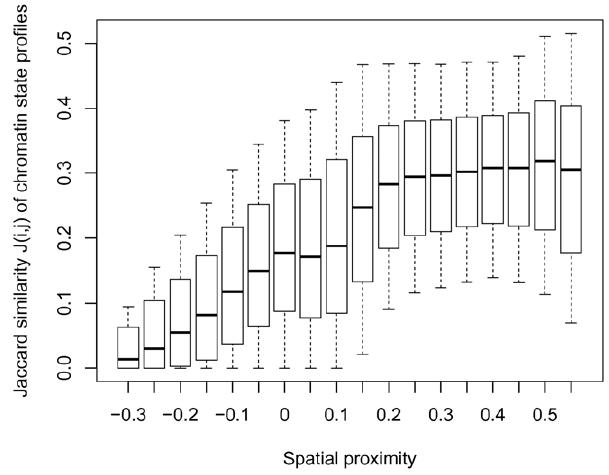
Figure 7. Correlation of the spatial proximity values with the similarity of chromatin state profiles. Whisker boxes are as in Fig. 1.